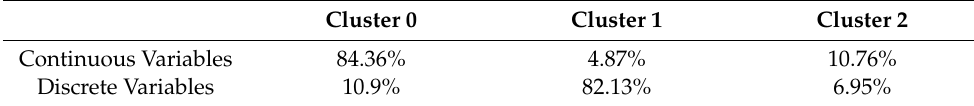
Table 2. K-means Table 2 . K-means results .